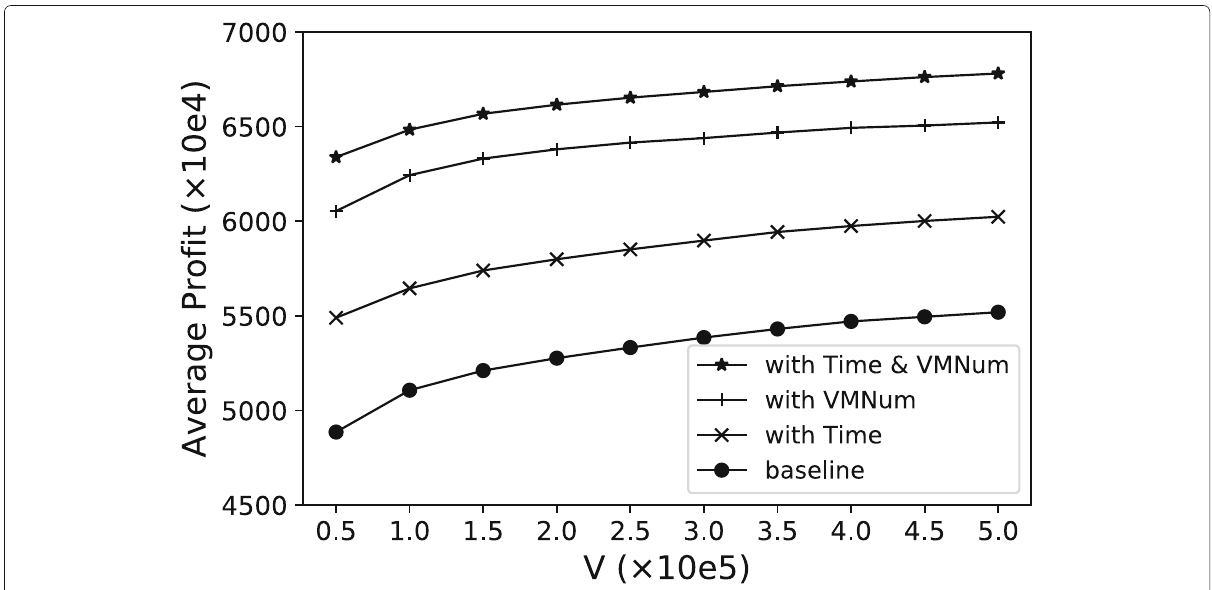
Fig. 6 Comparison of average profit for our algorithm with different values of V